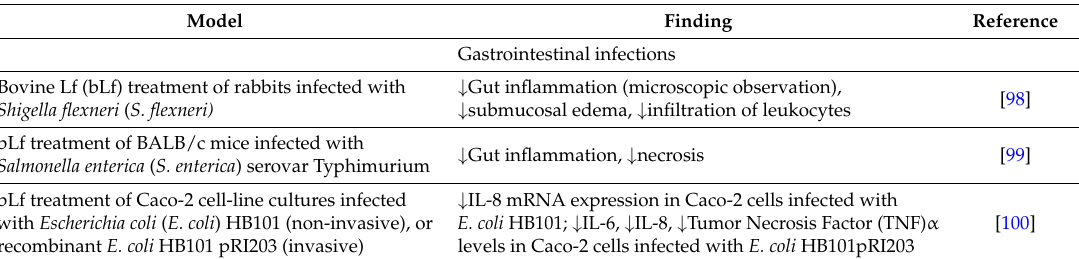
Table 1. Modulatory effects of lactoferrin on inflammation associated to